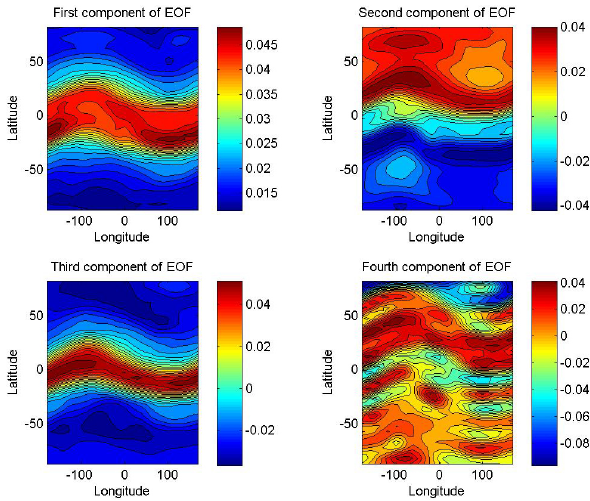
Figure 6. Same as Fig. 2 except for a spatial resolution of 36 × 35